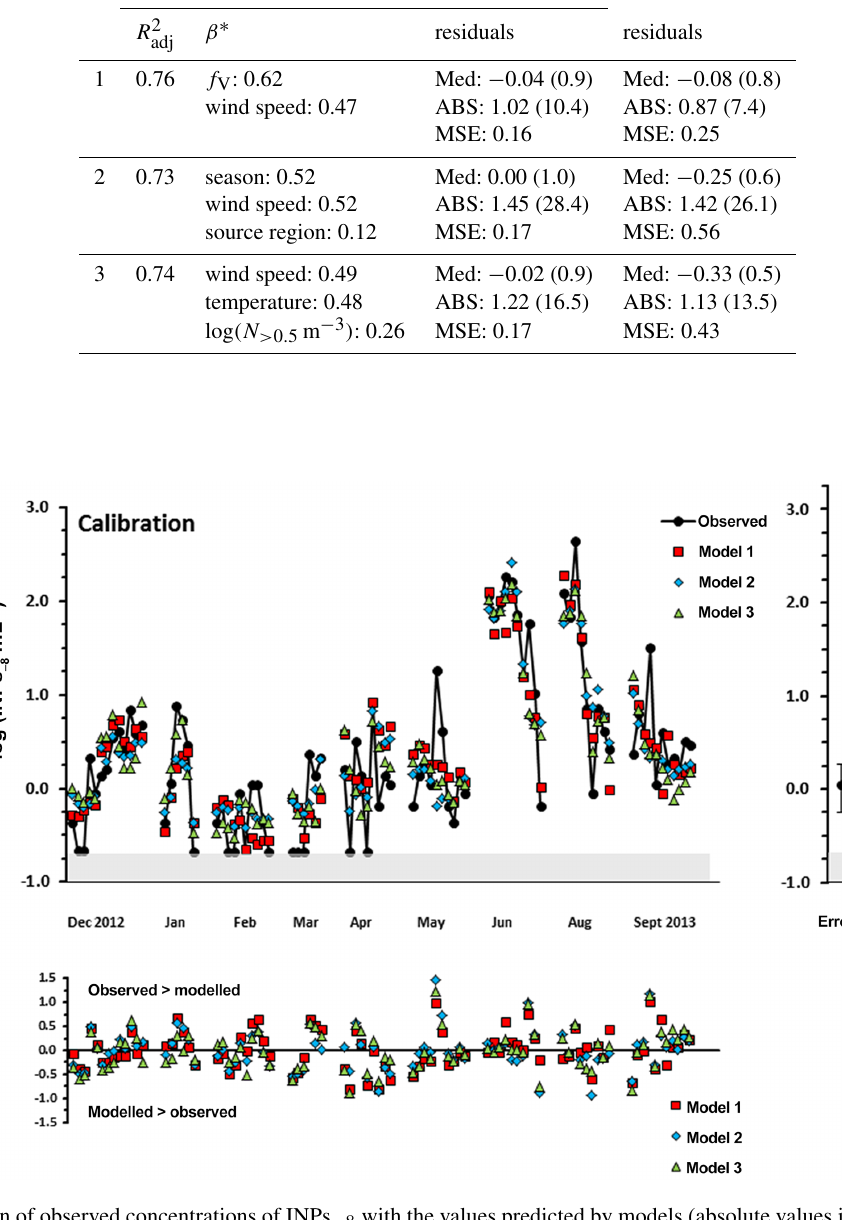
Figure 2. Comparison of observed concentrations of INPs − 8 with the values predicted by models (absolute values in upper panels, residuals in lower panels) for the data set used for calibration ( n = 84). The grey area in the upper panel indicates the range below the detection limit of our observation method. Time proceeds from left to right, intervals are not to scale, dots belonging to the same sampling campaign are connected by lines. Error bars associated to the measurement of 1, 10, 100, and 1000 INPs − 8 mL − 1 are represented close to the